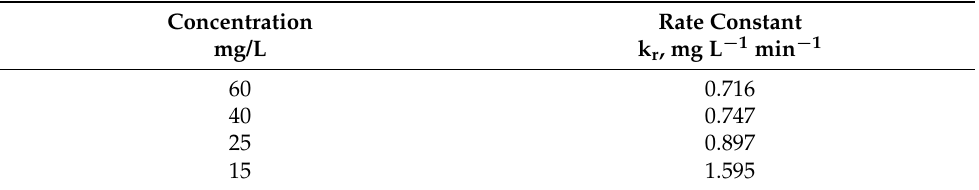
Table 3. Langmuir-Hinshelwood constant (k r ) values at different initial dye concentrations.